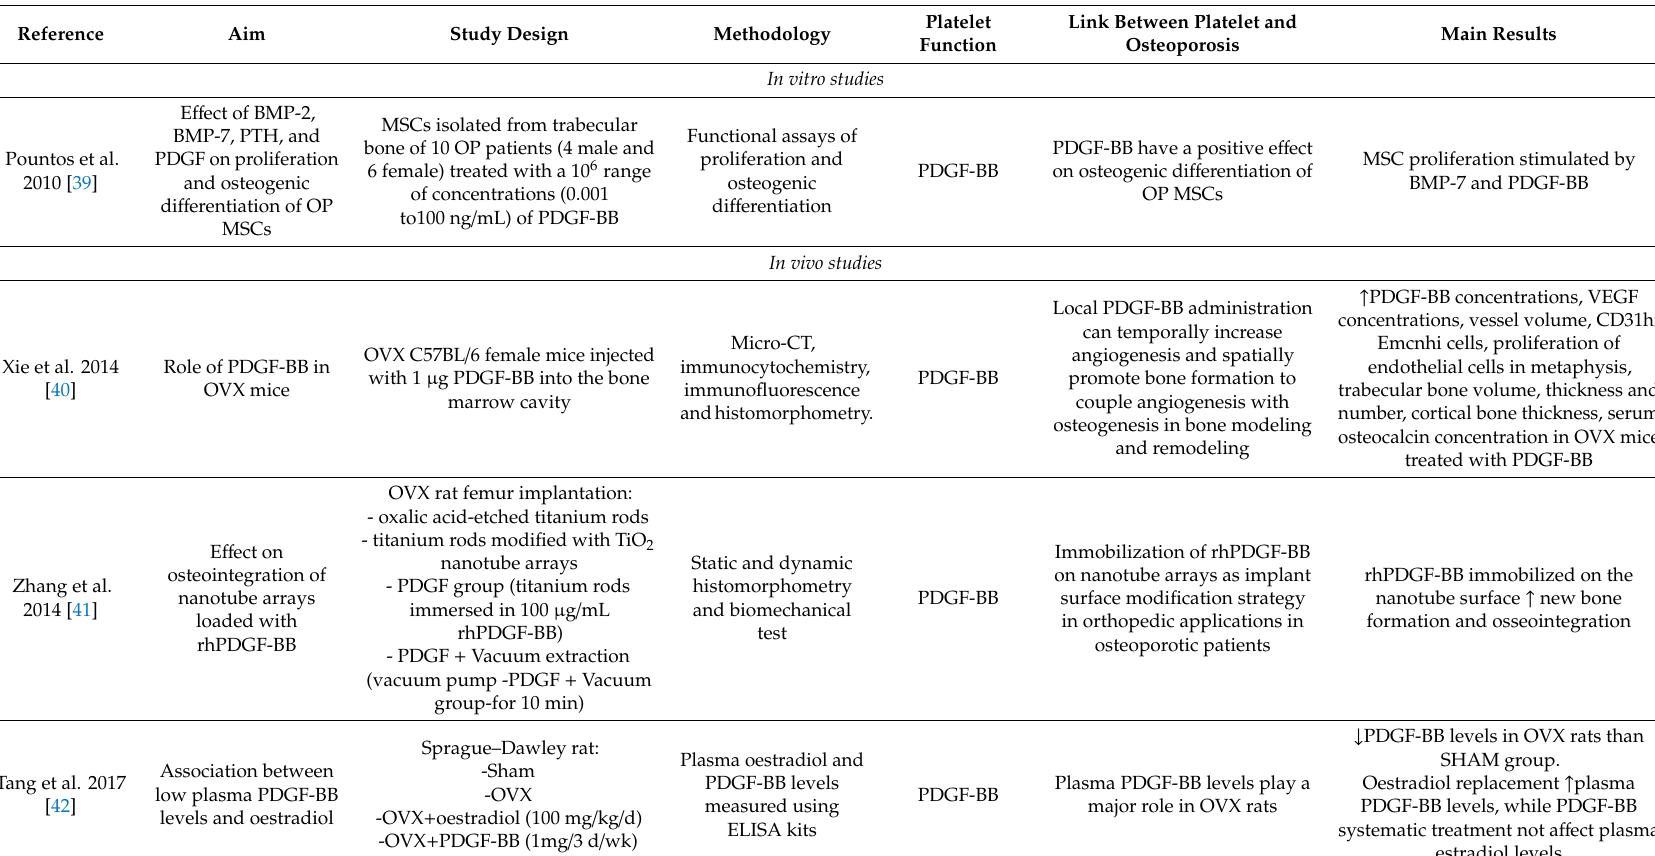
Table 2. Preclinical (in vitro and in vivo) and clinical studies on PLT functions / features and growth factor in PLTs during